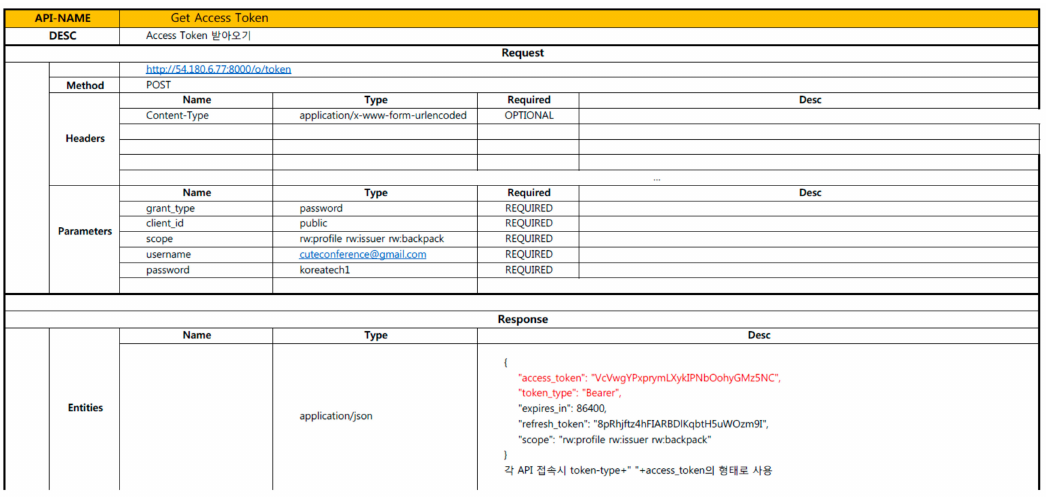
Figure 18. REST API for access token requirement.